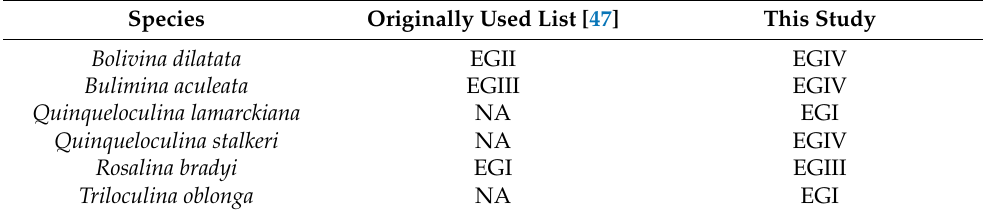
Table 1. Summary of ecological group changes from the originally used list [47] to this study’s updated